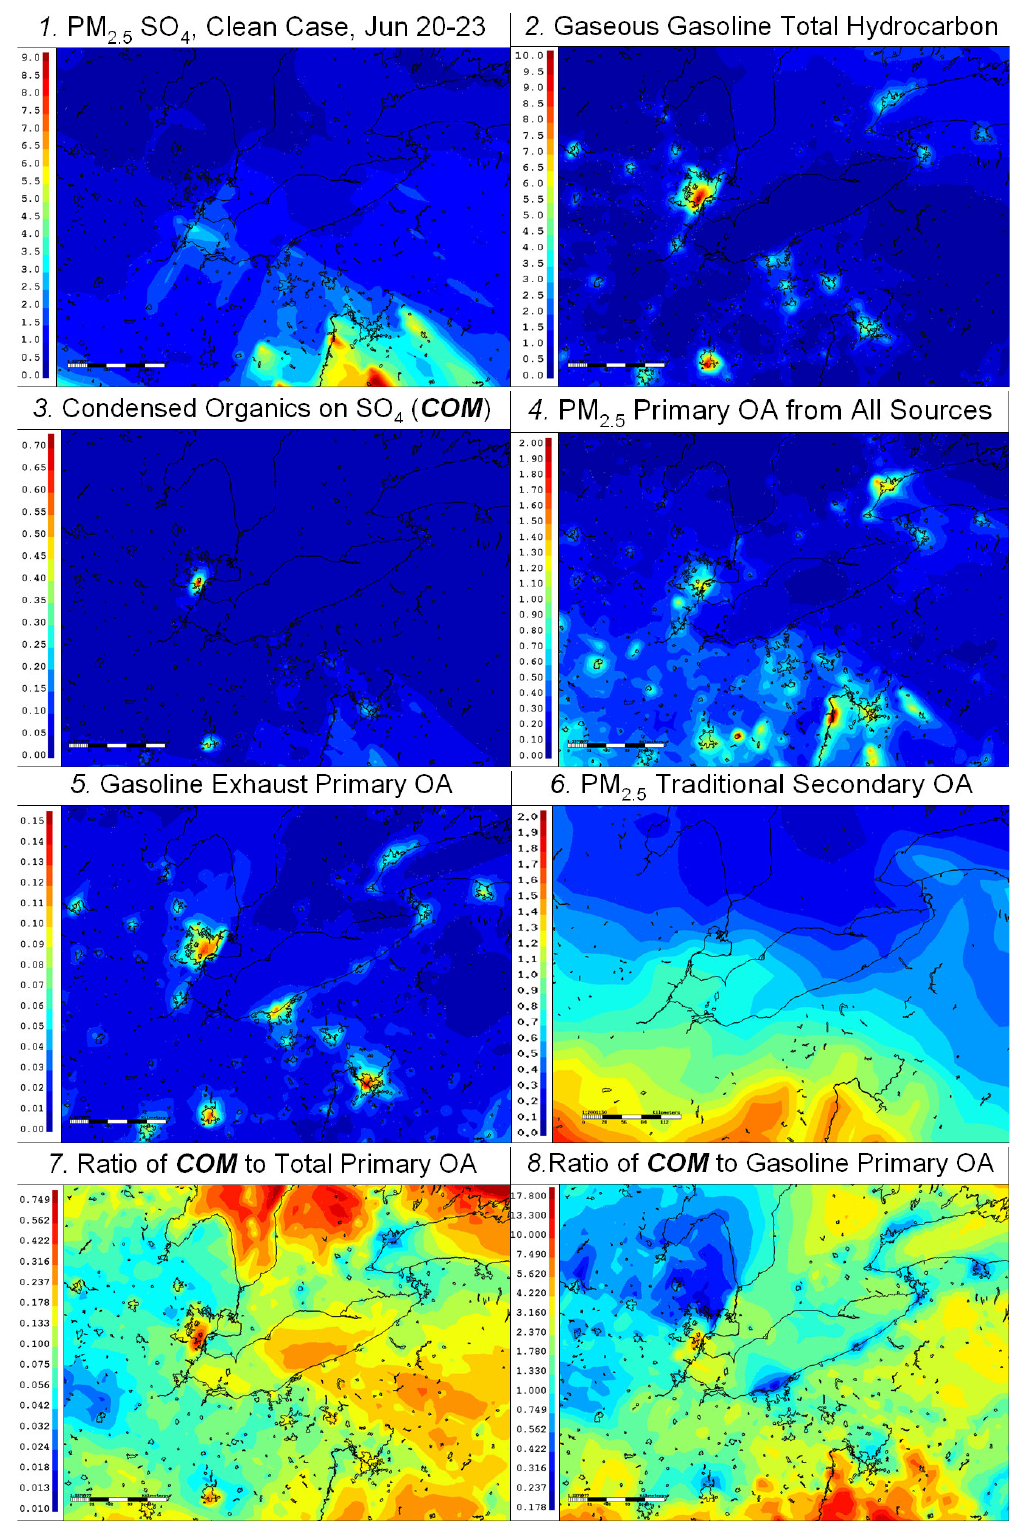
Figure 8. Same as Fig. 7 but for the clean case of June 20 12Z to June 23 12Z. Fig. 8. Same as Fig. 7 but for the clean case of 20 June, 12:00 Universal Time to 23 June, 12:00 Universal Time.